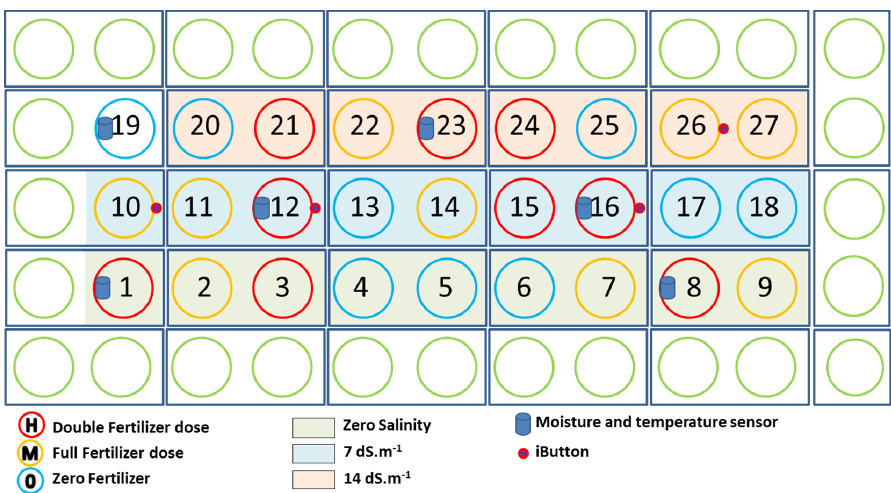
Figure 5. Cluster analysis of the relationships between SPAD ‐ 502 reading and the pigments at various levels of salinity and fertilizer application. ( A ) SPAD vs. total chlorophyll, ( B ) SPAD vs. total carotenoids content. The ellipses are calculated from the covariance matrix of the relationships. Whisker plots are superimposed on the data to illustrate the data spread ( n = 277).